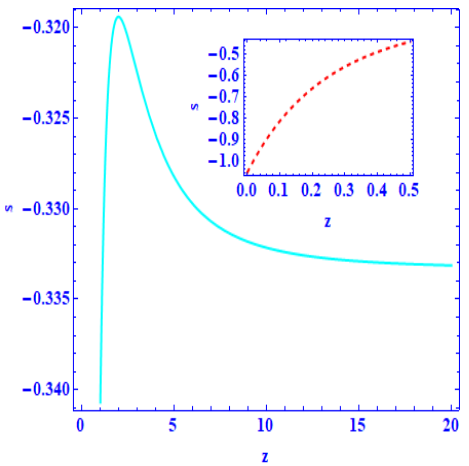
Figure 10. Plot of r versus z .